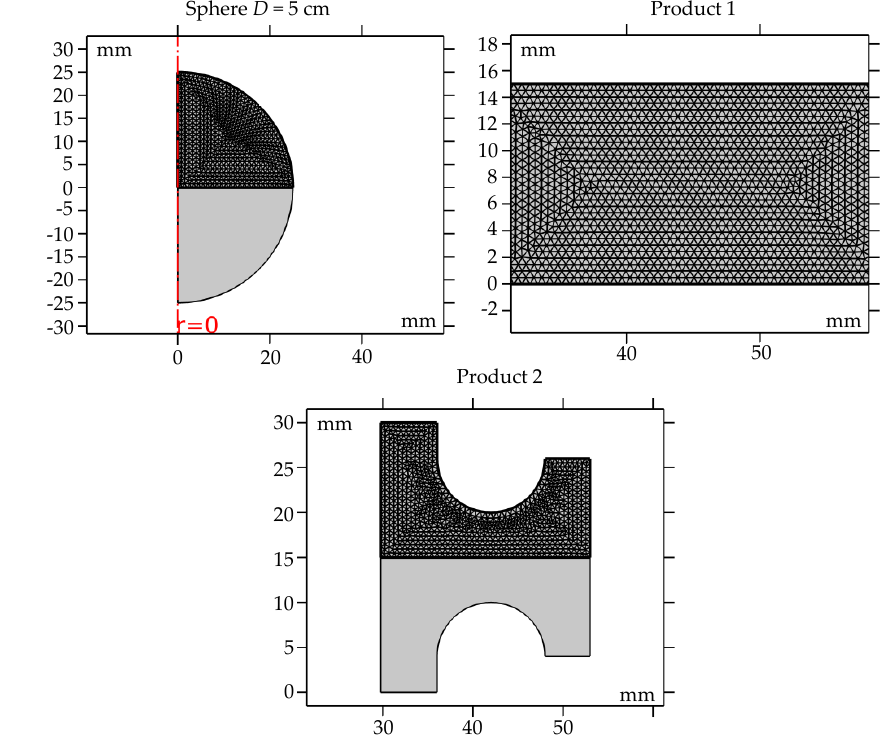
Figure 1. The domain of a particularly fine geometric mesh in selected